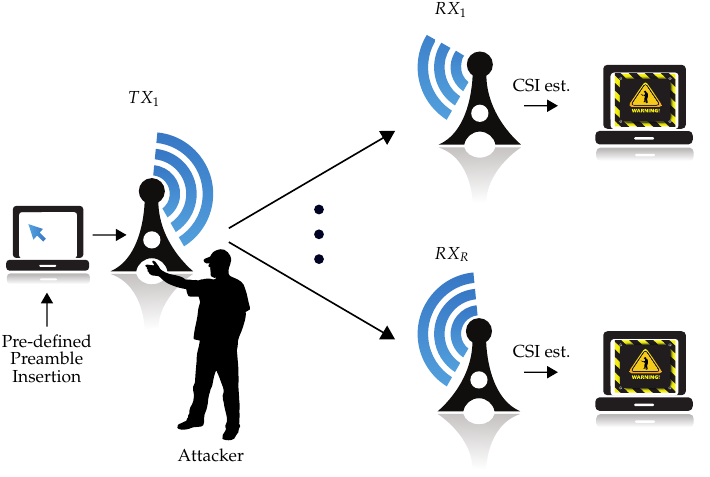
Figure 1. Problem